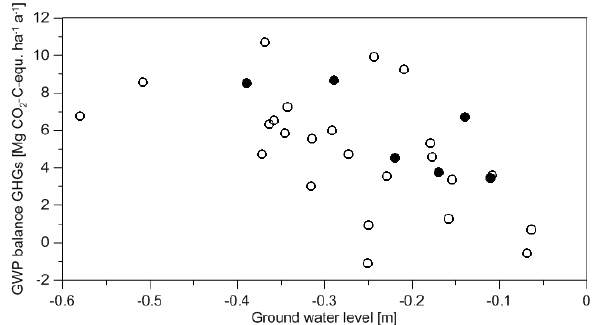
Fig. 3. Annual GHG balances vs. water table level of shallow peat sites in the Grosses Moor (filled circles) and several deep peat grass- land sites (open circles) in Germany (Drösler et al.,